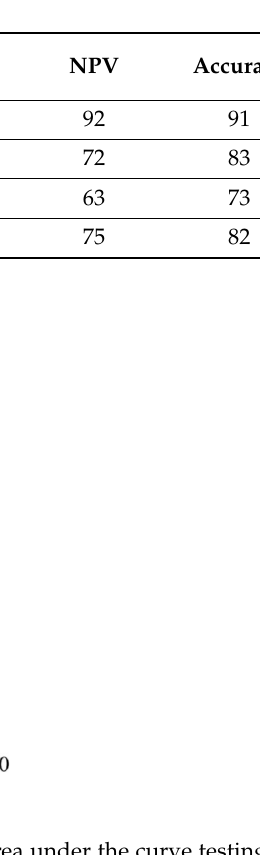
Table 2. RWT = relative wall thickness, RELAPS = relative apical sparing, and PWT = posterior wall thickness.